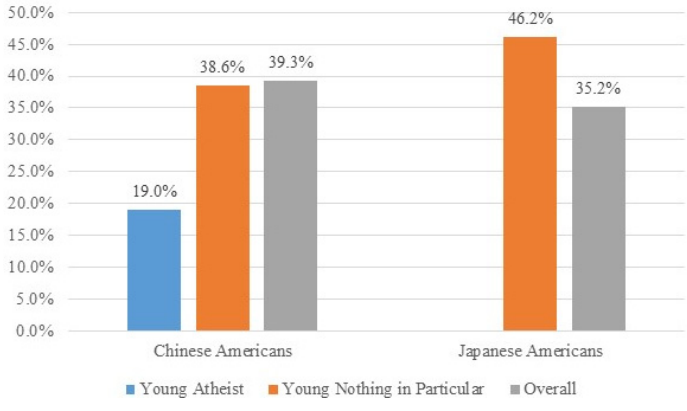
Figure 6. Belief in spiritual energy.